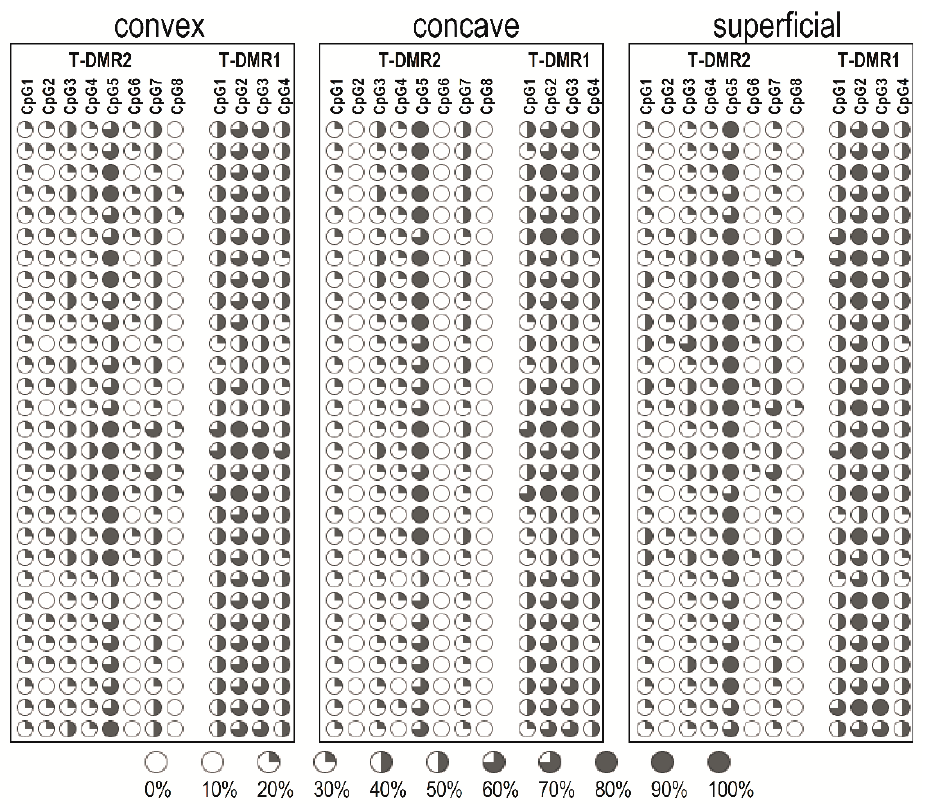
Figure 2. Dot plot of ESR1 T-DMR1 and T-DMR2 regions methylation pattern of individual patients.